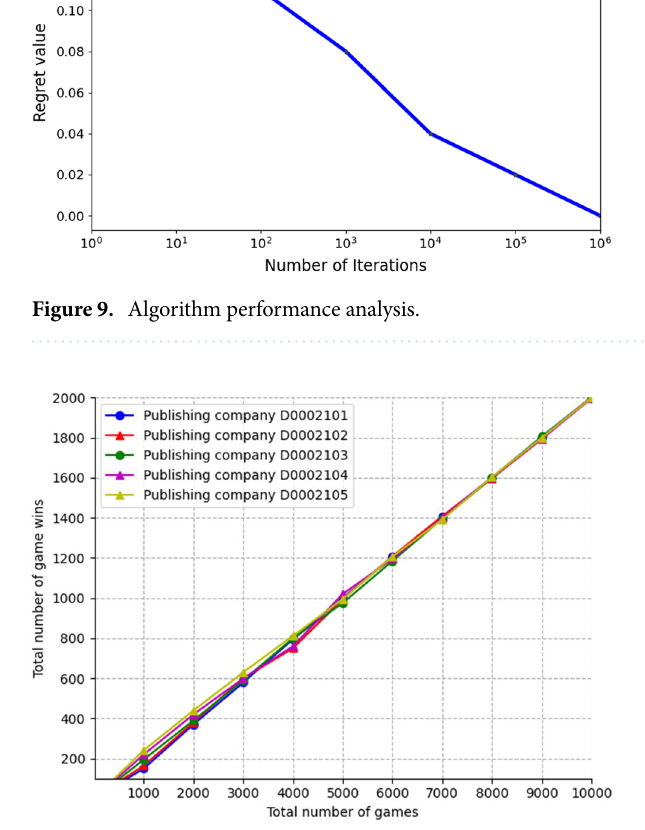
Figure 10. Game efficiency analysis.